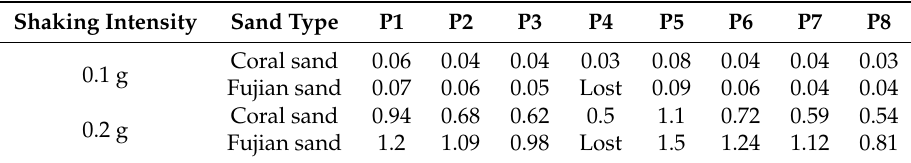
Figure 7. Excess pore pressure ratio time history curves under 0.1 g shaking intensity: ( a ) P1 position; ( b ) P2 position; ( c ) P3 position; and, ( d ) P4 position. Table 4. Comparison of peak excess pore pressure